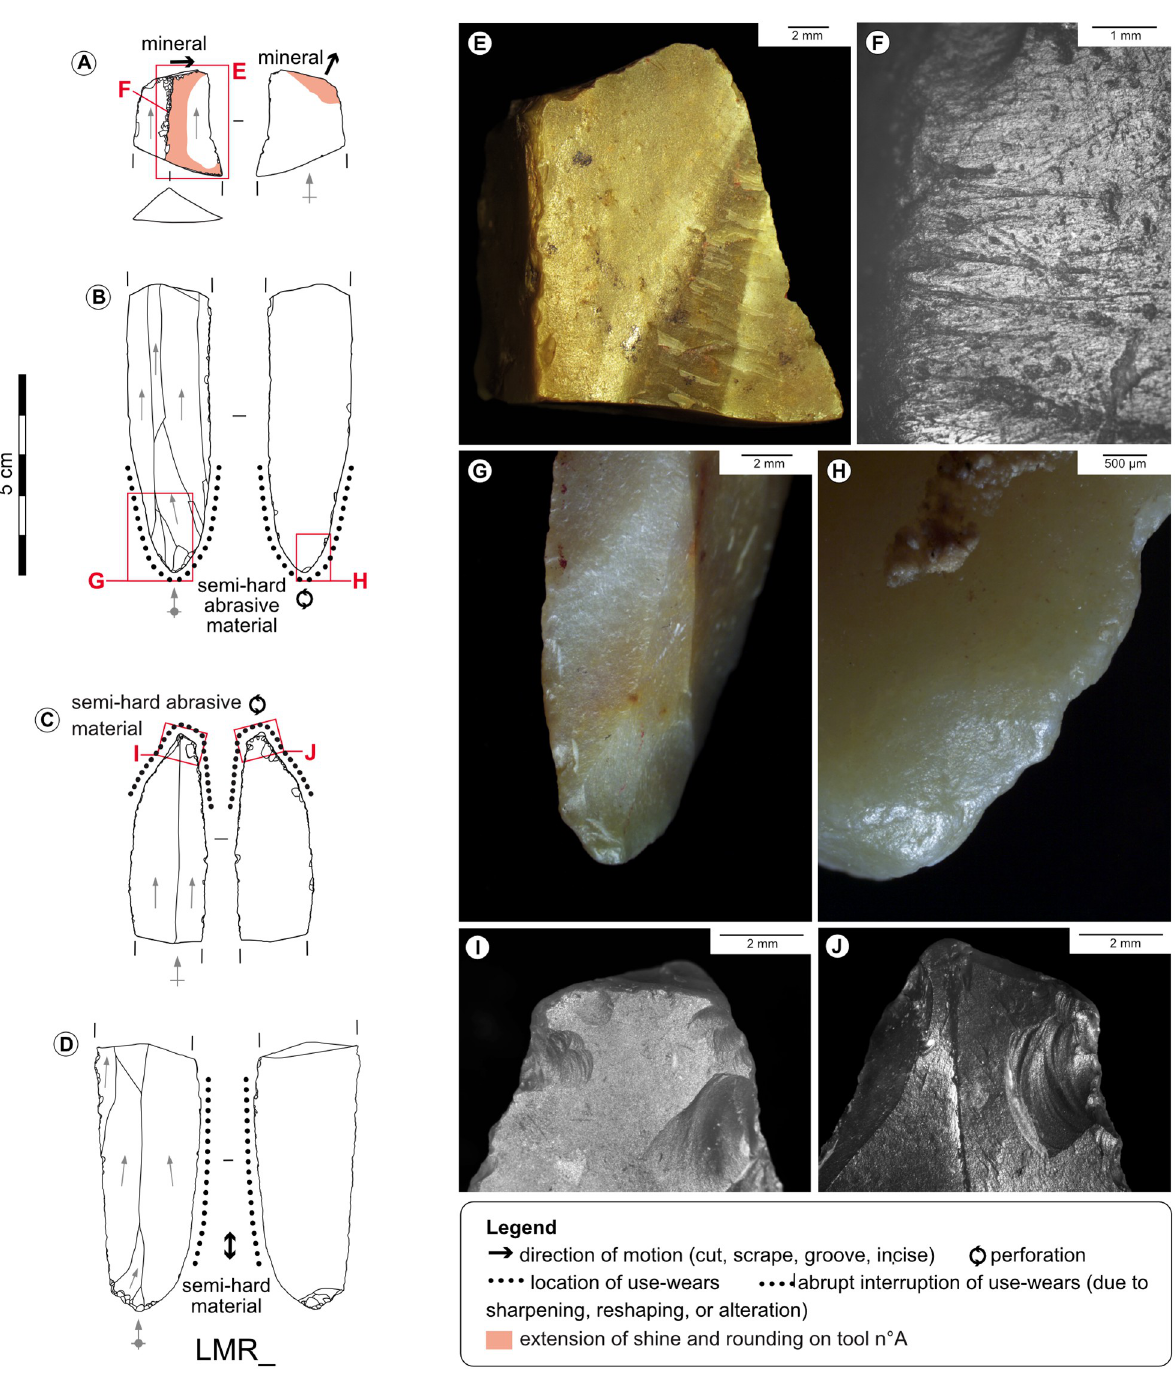
Fig 13. Diversity of zones used on unretouched blades. A-Mesial fragment of blade from the Blanchard cave, layer B4. B-Broken blade from the Blanchard cave, layer B3. C-Broken blade from the Blanchard cave, layer B4. D-Broken blade from La Marche. E, F-Traces of mineral scraping on the ridge of tool n˚A, credits: Gauvrit Roux, 2019. G, H-Perforating traces on the proximal end of tool n˚B. I, J-Perforating traces on the distal end of tool n˚C.